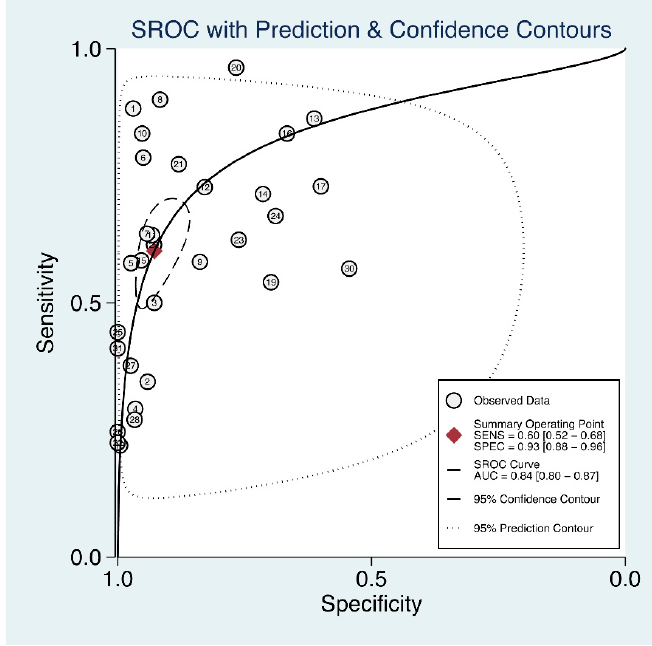
Figure 3. Summary receiver operating characteristic curve.